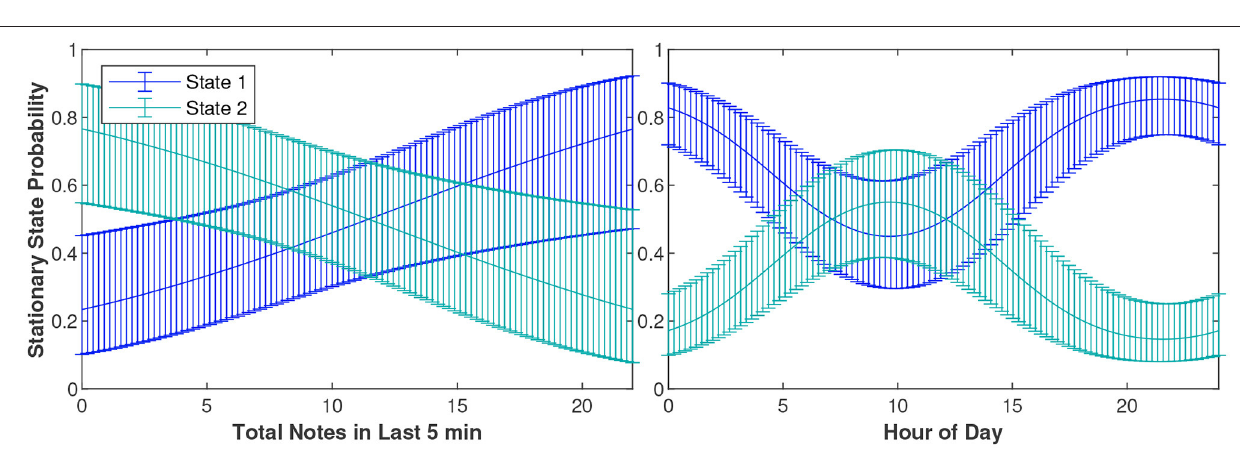
FIGURE 6 | The probability of a fin whale being in State 1 or 2 based on the total notes it produced in the last 5 min and the hour of the day. The blue and teal curves show the Stationary State probabilities of State 1 and State 2, respectively. The error bounds show the 95% confidence intervals. For the left plot, the hour was held constant at its mean value of 11.87 and for the right plot, the total notes produced in the last 5 min was held constant at its mean value of